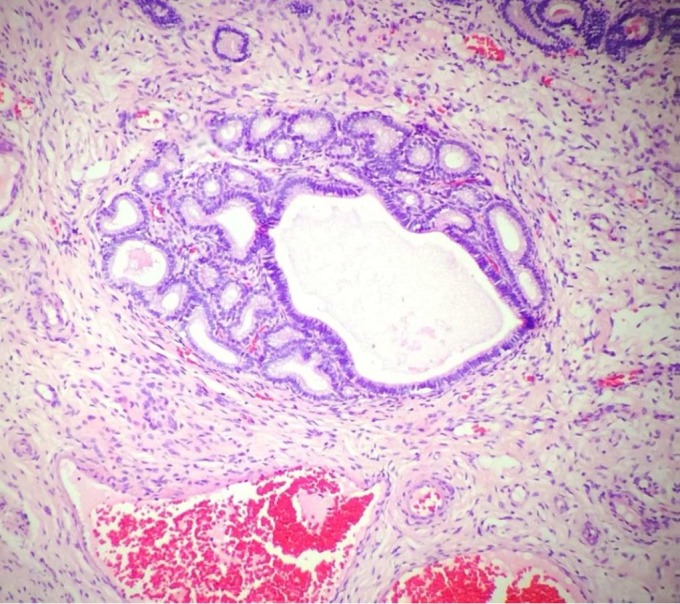
Gynecological examination in Pantaneiro mares. Endometrial biopsy in mare 4 shows moderate proliferation of the fibrous conjunctive tissue, the formation of a glandular island, and glandular dilation. Hematoxylin-eosin, 10×.